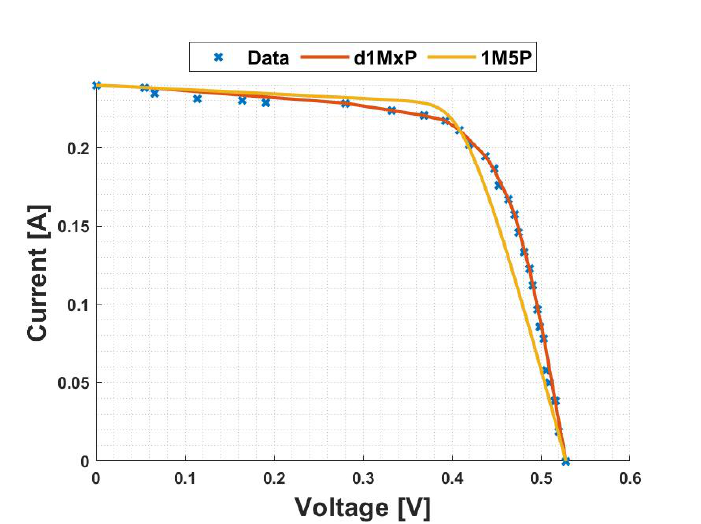
Figure 10. I-V curves using the 1M5P model and the proposed model, at T = 50 ◦ C.